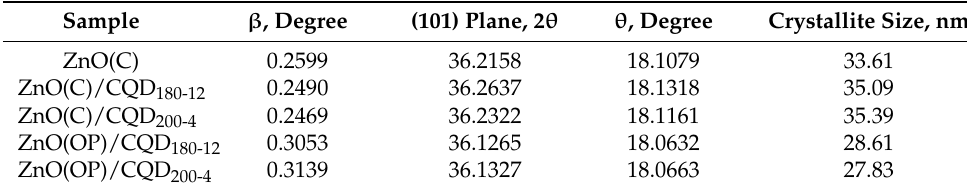
Table 1. The crystallite size of the ZnO/CQD nanocomposites.